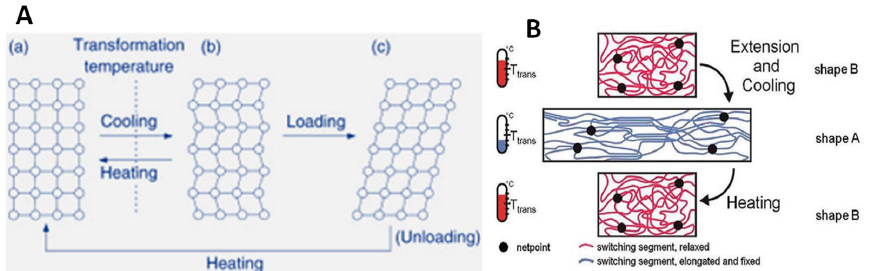
Figure 2. ( A ) Changes in crystalline structure during shape memory effect of alloys and ( B ) mecha- nism of shape memory in polymers. (Reproduced with permission from [18,33], Elsevier, 2009).